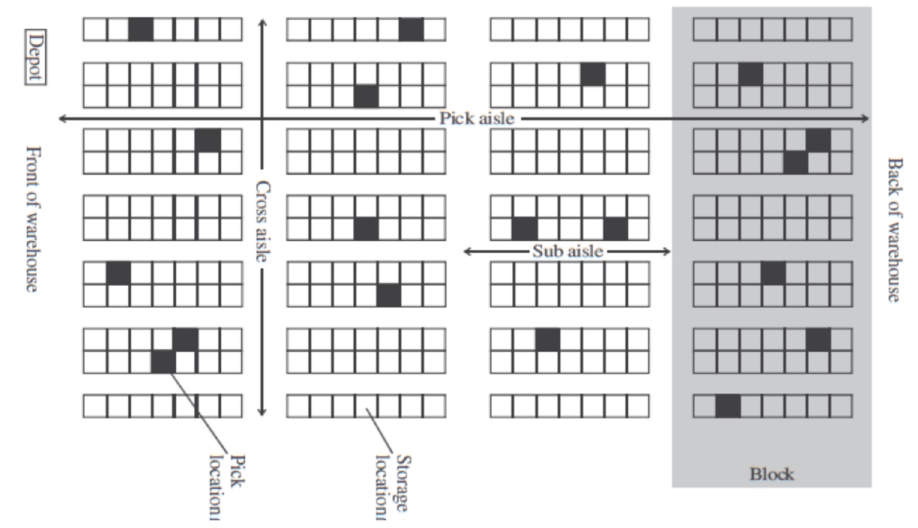
Figure 5. Order-picking Area in Stock [29].